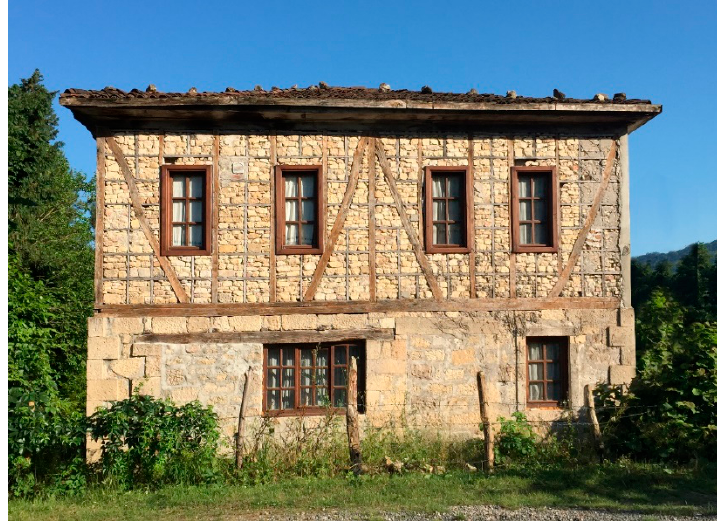
Figure 5. (a) Wooden facade with stone as filling material (Photographed by Ömer Faruk Bayram); (b) Relation of wood and stone in detail (Photographed by Ömer Faruk Bayram).